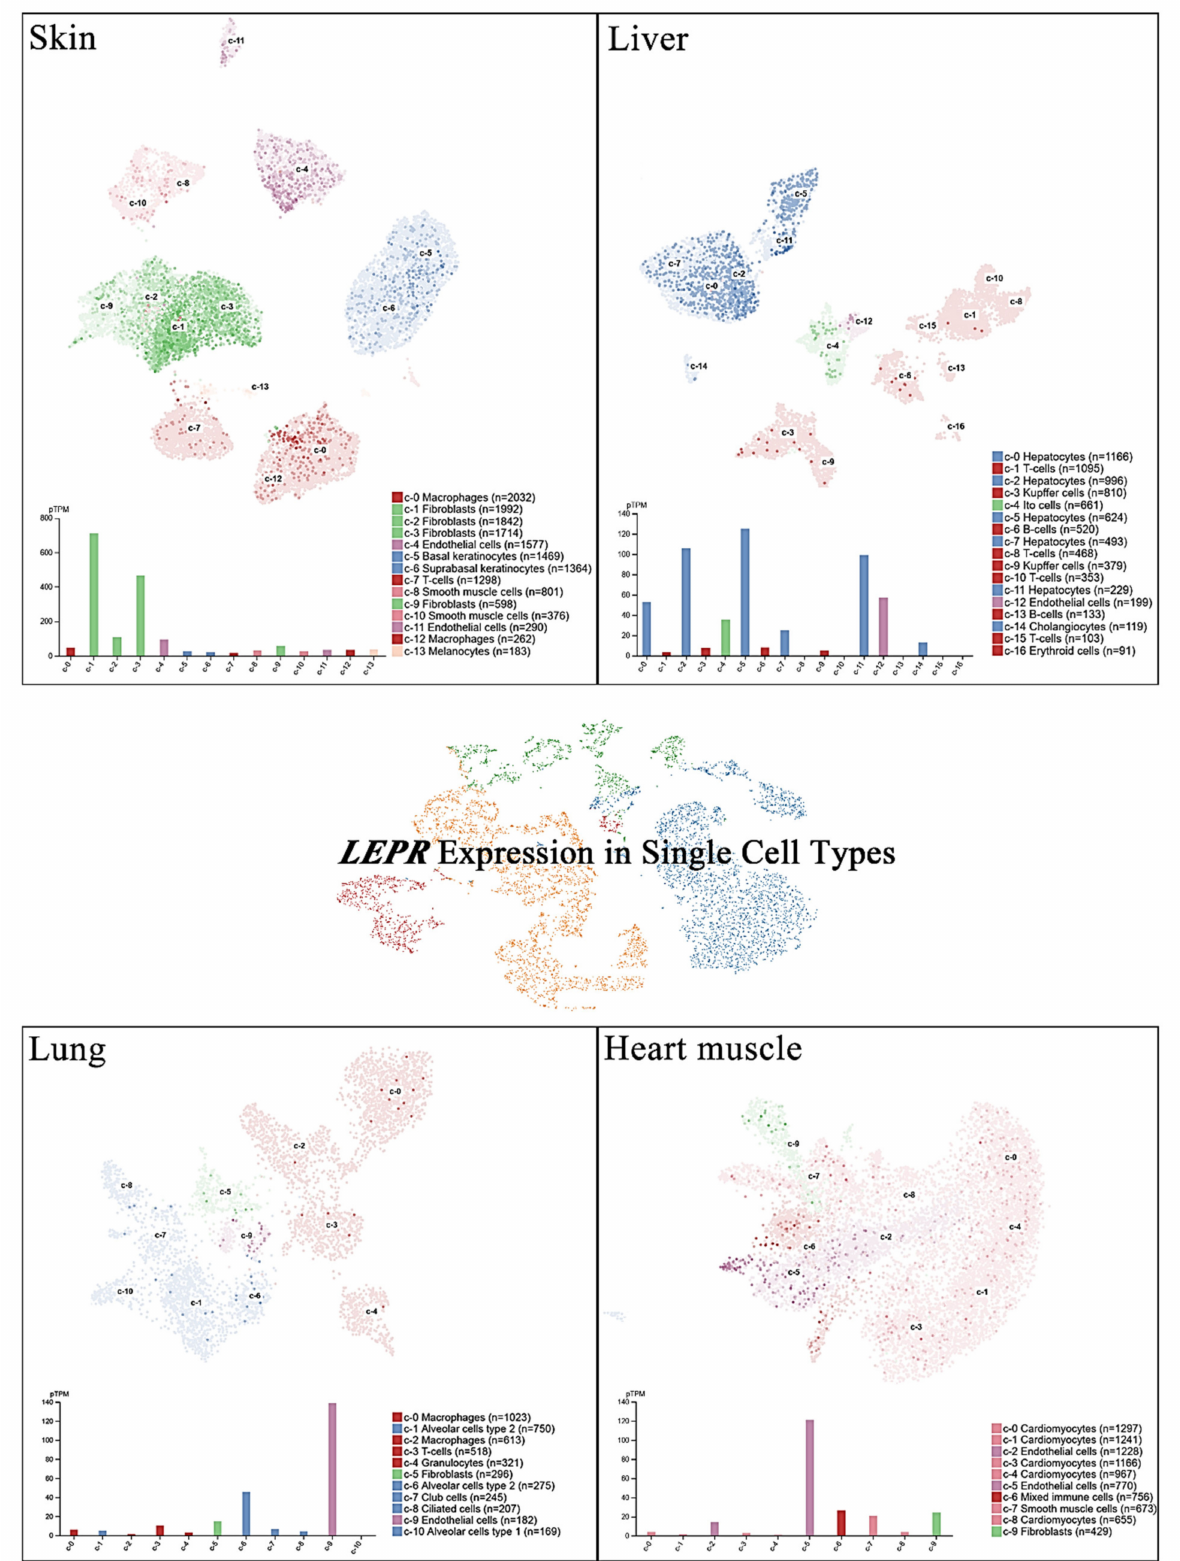
Figure 2. LEPR expression in single cells of different types. The LEPR expression level was analyzed by single-cell RNA sequencing (scRNA-seq) in various human tissues. The RNA expression levels in the cell type clusters identified in each tissue were visualized by a UMAP plot of single cells ( top ) and in a bar chart ( bottom ). The read counts were normalized to transcripts per million protein-coding genes (pTPM) for each